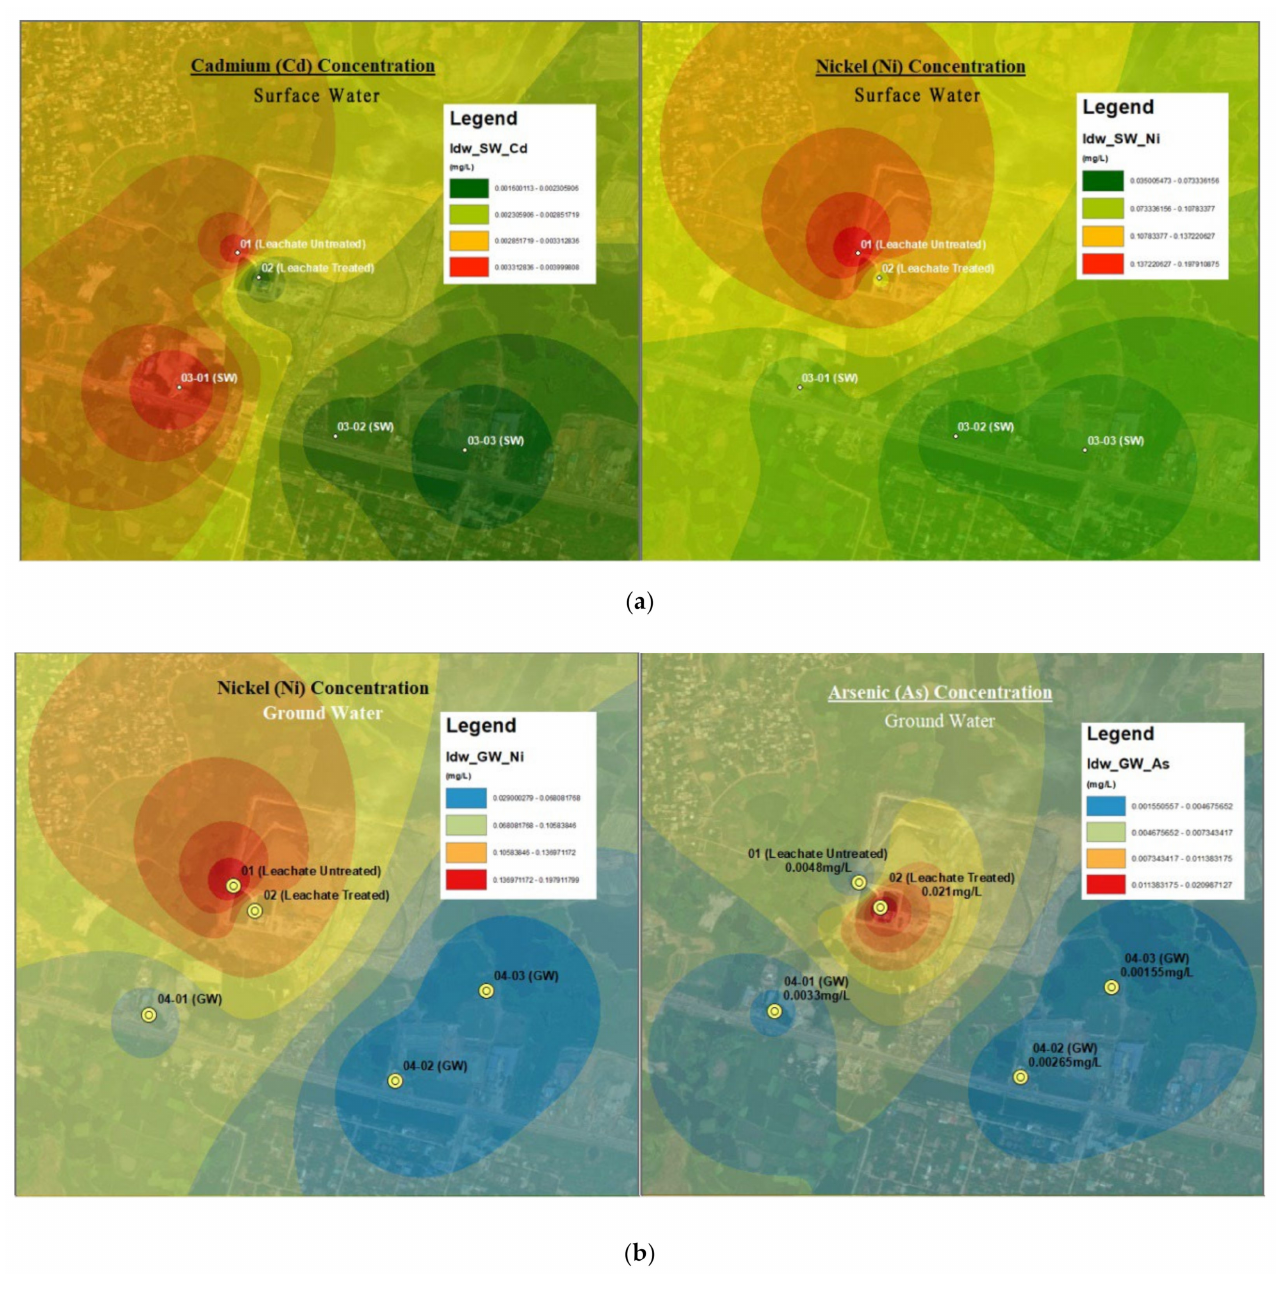
Figure 5. IDW of ( a ) Cd and Ni concentration in surface water and ( b ) Ni and As concentration in groundwater. The same goes for the Pb and Cd in the soil and plant samples (Figure 6). The concentration of Pb, Cd, and Ni shows the most acceptable result based on IDW. Sample 06- 01 and sample 06-03 were closer to the landfill site and sample 06-02 was farther. Therefore, the concentration of all these heavy metal(loid)s was higher in samples 06-01 and 06-03. More GIS analysis of soil and plant has been added in Supplementary Figure